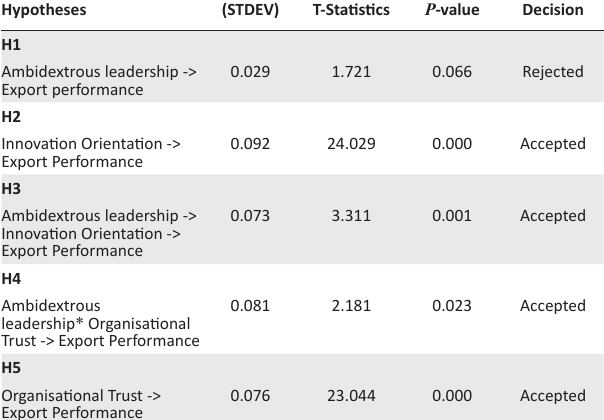
FIGURE 3 : Significance model. TABLE 4: Summary Result on Hypotheses on Ambidextrous Leadership, Innovation Orientation and Export Performance: Moderating role of Organisational Trust.